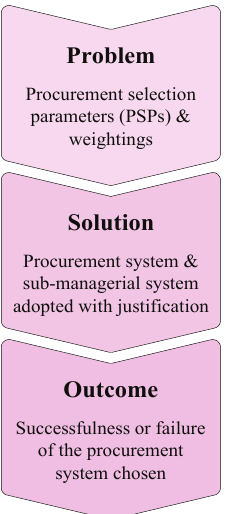
Figure 2: Knowledge pertinent to procurement selection